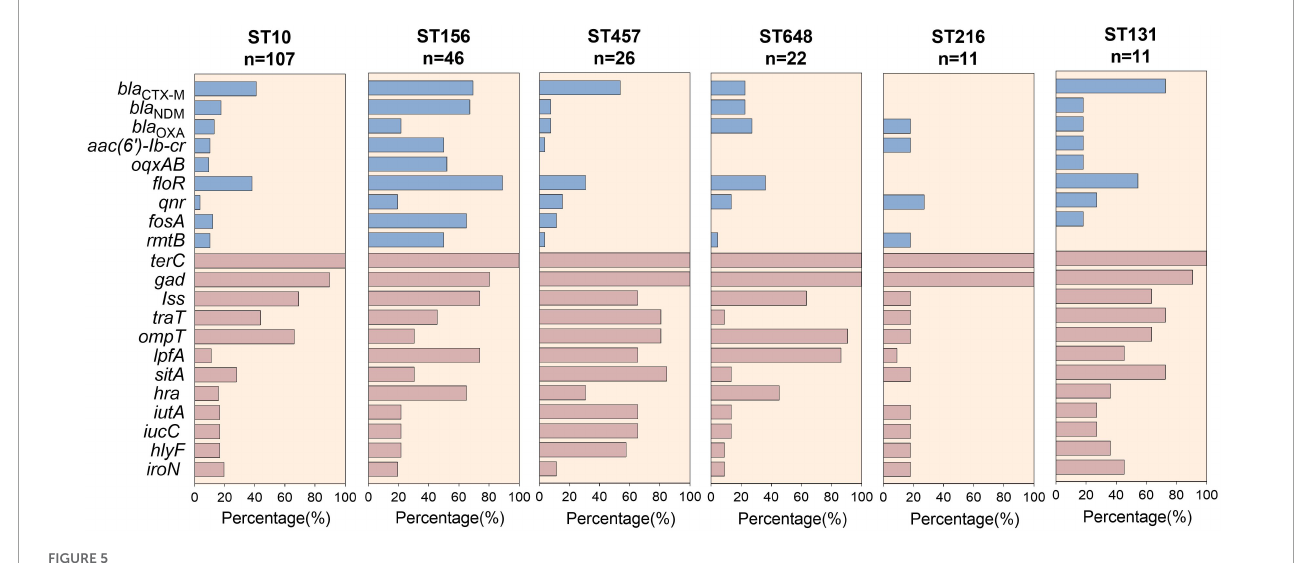
FIGURE5 Carriage of antimicrobial resistance genes and virulent factors among globally prevalent ST